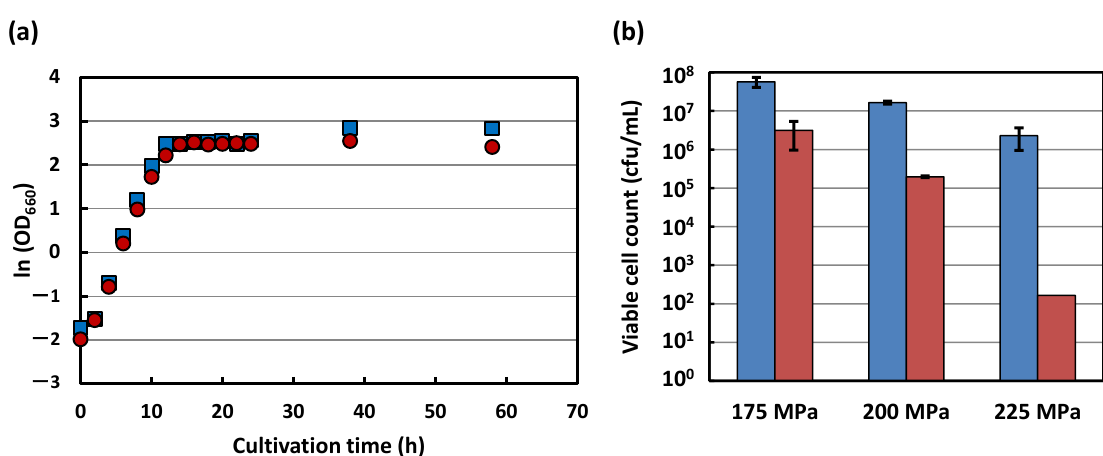
Figure 1. Typical growth curves of strains KA31a (wildtype; blue boxes) and a924E1 (piezosensitive mutant; red circles) ( a ). Cells were grown for 60 h at 30 °C in YPD medium. The time courses of optical densities at 660 nm (OD 660 ) are presented as a semi-logarithmic plot. The viable cell count of the strain KA31a (blue boxes) and a924E1 (red boxes) after HHP treatment ( b ). After 48 h cultivations, both strains were subjected to HHP treatment at 175, 200, and 225 MPa at ambient temperature for 360